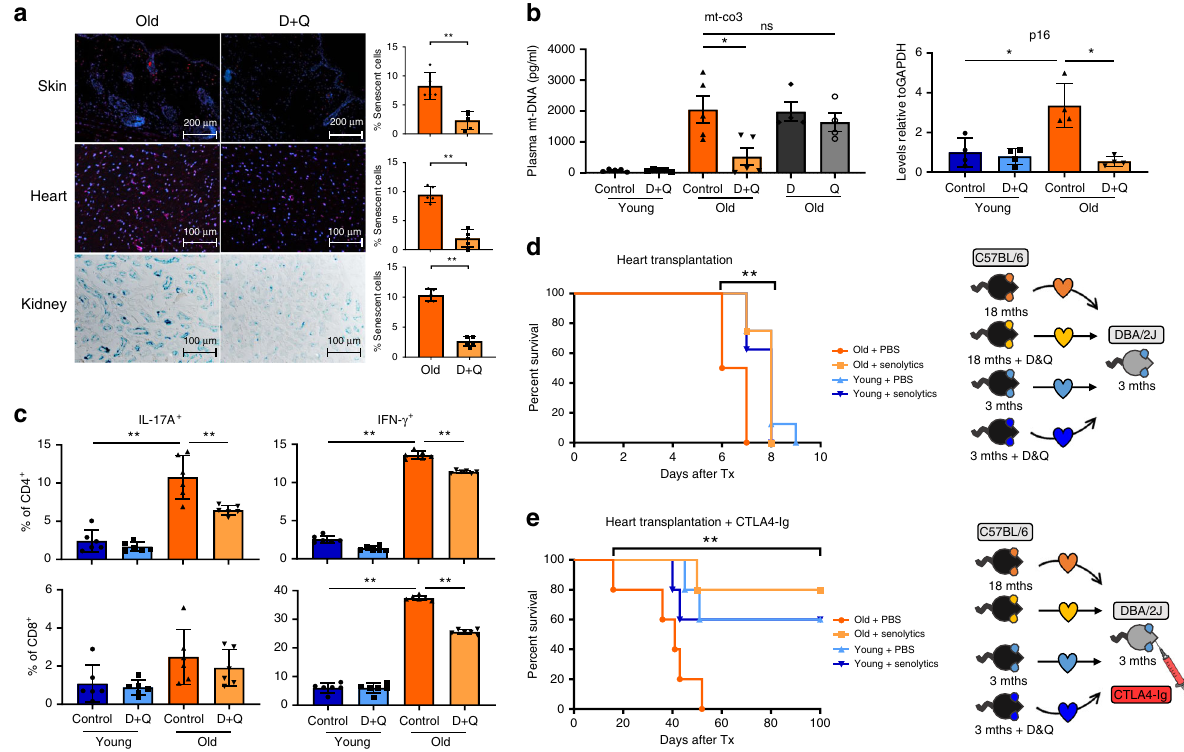
Fig. 6 Senolytics decrease the number of senescent cells, reduce cf-mt-DNA levels, alleviate systemic in fl ammatory immune response after IRI, and prolong cardiac allograft survival. a Old C57/B6 mice were treated with senolytics (D and Q, or either D or Q in b ) on 3 successive days/week. After 1 month, kidney, heart, and skin were procured, stained, and the percentage of senescent cells assessed as described in Fig. 4, ( p = 0.0079); Column plots display mean ± SD, ( n = 5 biologically independent animals). b Systemic levels of p16 Ink4a and cf-mt-DNA were measured by real-time PCR and calculated relative to GAPDH expression (old vs. old + D and Q: p = 0.0317); Column plots display mean ± SEM, ( n = 6 biologically independent animals). c Young and old C57BL/6 mice were treated with senolytics for 3 successive days/week for 1 month. Subsequently, IRI was induced in young and old animals; IL-17 and IFN- γ expression of CD4 + and CD8 + T cells were assessed by fl ow cytometry (old control vs. old treated: CD4 + IL-17 + ( p = 0.0087)/CD4 + IFN- γ + ( p = 0.0022)/CD8 + IFN- γ + ( p = 0.0022); column plots display mean ± SD, ( n = 6 biologically independent animals). d Old and young donor C57BL/6 mice were treated with D and Q or PBS prior to fully mismatched cardiac transplantation and allograft survival was monitored by daily palpation ( p = 0.0012); ( n = 8 biologically independent animals). e Old and young donor C57BL/6 mice were treated with D and Q or PBS prior to fully mismatched cardiac transplantation while recipient animals were treated with weekly injections of CTLA4-IG following transplantation and allograft survival was monitored by daily palpation ( p = 0.0064); ( n = 5 biologically independent animals). Results are representative of at least three independent experiments. Statistical signi fi cance was determined by two-tailed Mann – Whitney test. Survival was compared by log-rank Mantel – Cox test. Asterisks indicate p